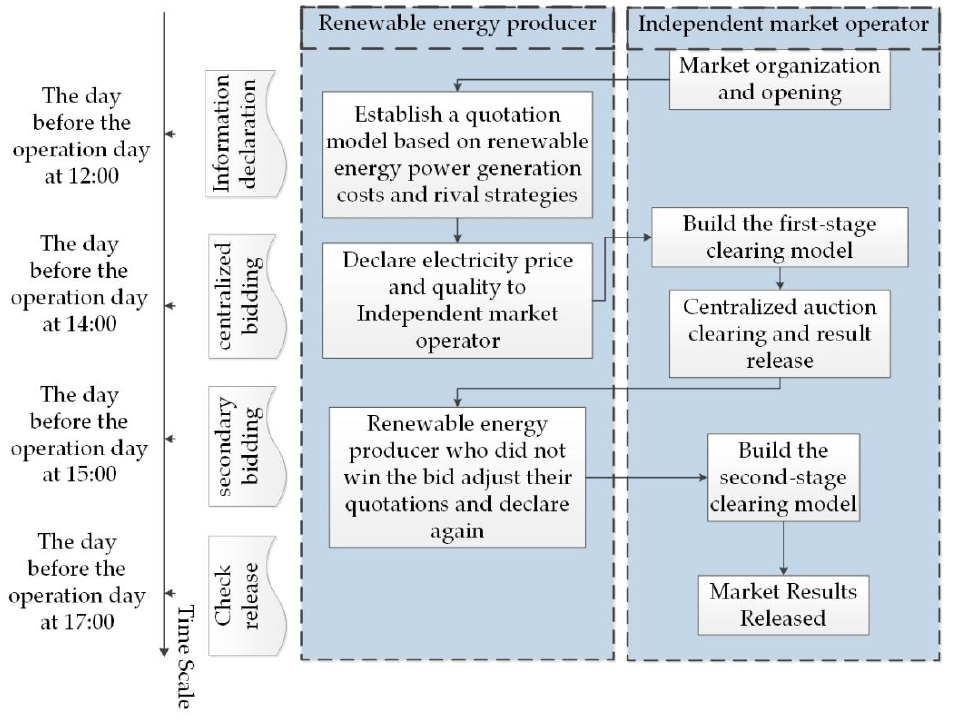
Figure 1. Day-ahead electricity market transaction framework.